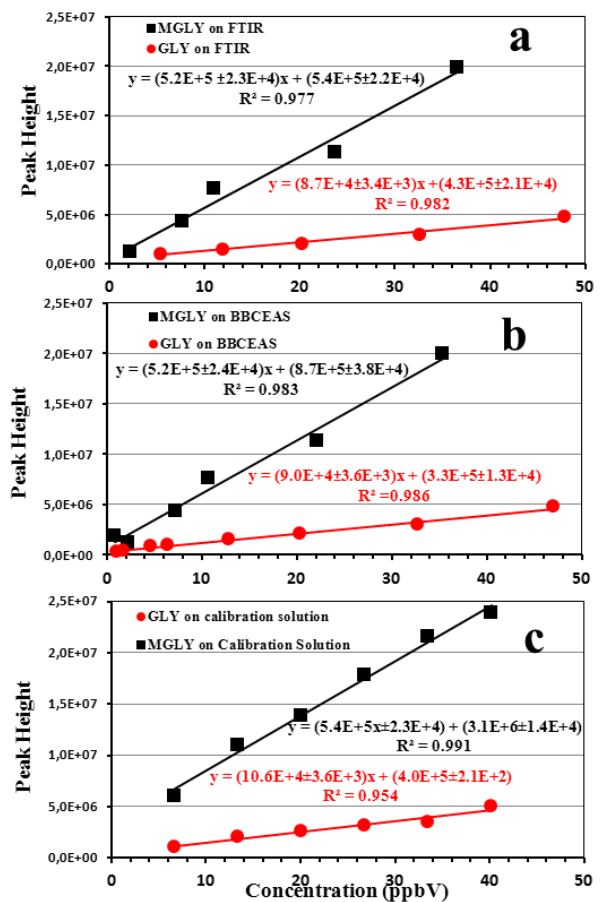
Fig. 4. Calibration curves of GLY and MGLY based on the abso- lute α -dicarbonyl data provided by FTIR panel (a) and by BBCEAS panel (b) measured by the microfluidic derivatisation technique un- der the optimal conditions. Calibration curves of GLY and MGLY in panel (c) are established by the calibration solution of α -dicarbonyl derivatives. The uncertainties of the slopes are less than